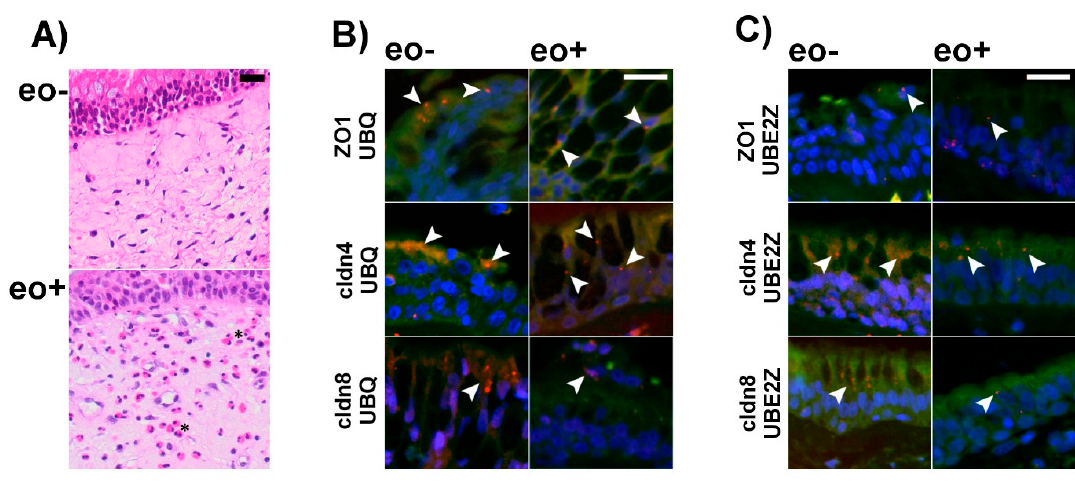
Figure 7. Proximity ligation assays (PLA) were performed on formalin fixed and paraffin embedded tissue from the sinunasal tract containing respiratory type epithelium of patients with and without eosinophilic inflammation. ( A ) shows representative Hematoxilin and Eosin stained images from nasal mucosa with (eo + ) and without (eo − ) eosinophilic inflammation. Eosinophilic granulocytes can be detected as reddish stained cells in eo + mucosa (examples are highlighted by asterix) but were not detected in eo- mucosa. For the PLA merge images of nuclear counterstain (blue), autofluorescence (green) and PLA signals (red) are shown. Antibodies specific for ZO1, Claudin 4 and Claudin 8 were combined with antibodies detecting Ubiquitin ( A ) and Ube2Z ( B ). Specific PLA reaction signals (depicted by arrow heads) can be detected in the epithelium under all conditions, suggesting association between ZO1, Claudin 4 and Claudin 8 with Ubiquitin and UBE2Z respectively. Scale bars are 20 µm in panels A, B and C.